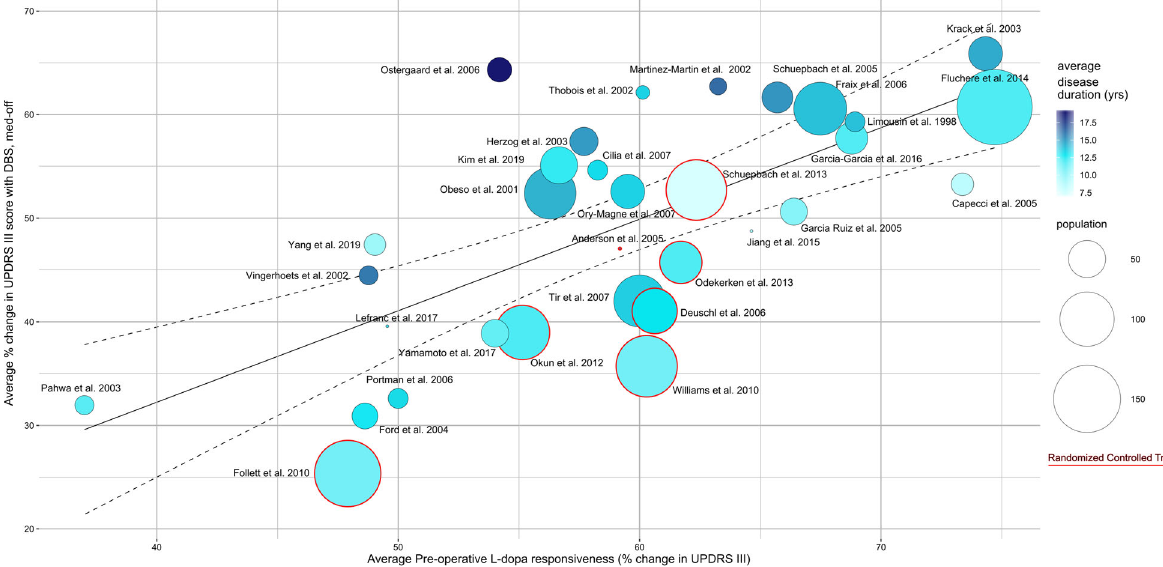
Fig. 4 Preoperative L-dopa response predicts STN-DBS motor outcome. Dose-response relationship between preoperative L-dopa response and improvement in UPDRS-III after STN-DBS, considering average disease duration (color shade), study population size (circle diameter), and randomized controlled trials (red frame). Studies reviewed indicated by fi rst author and year of